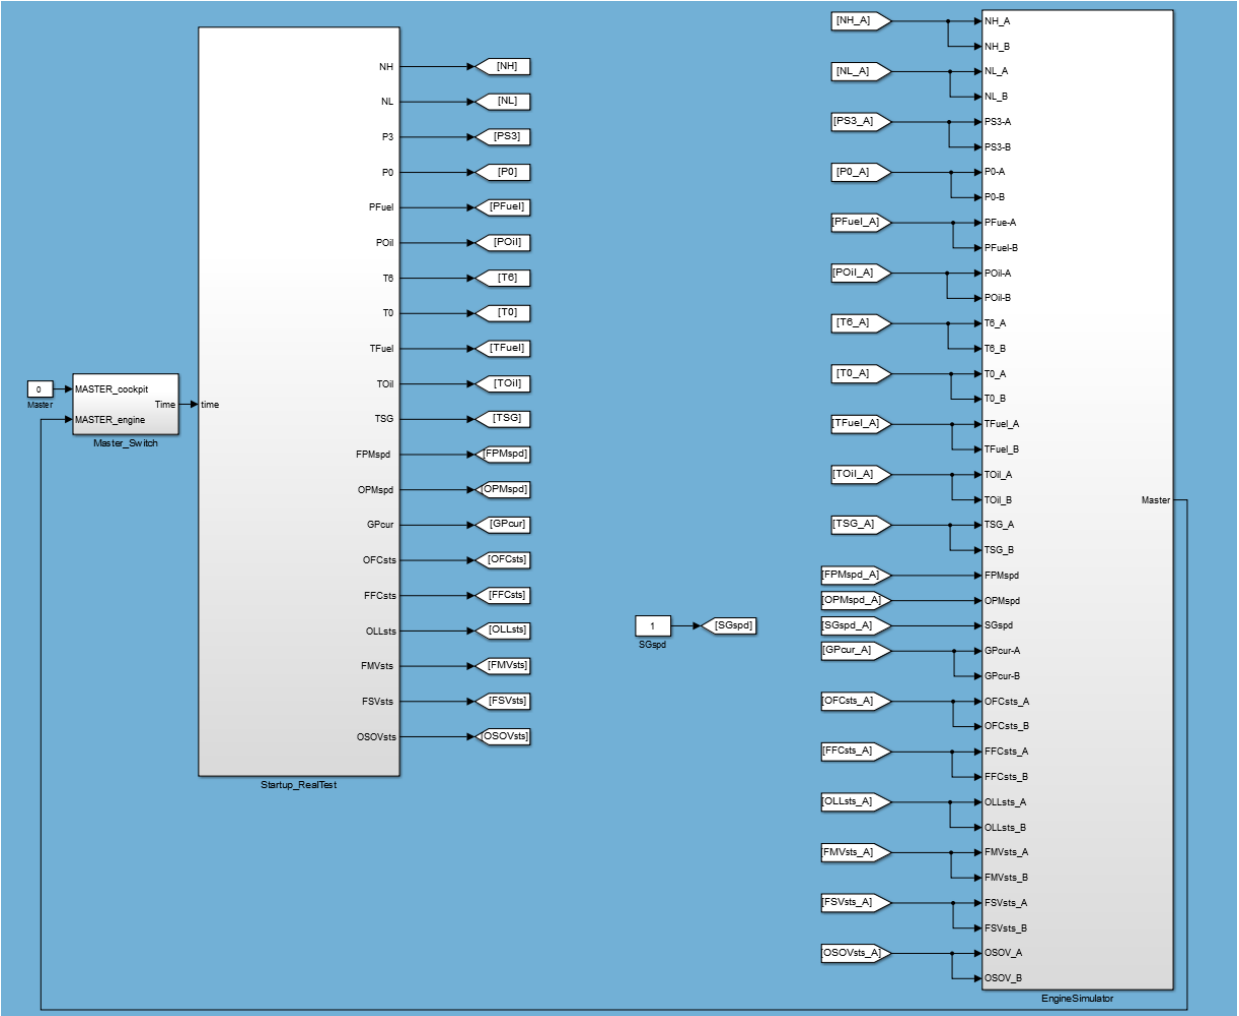
Figure 3. Real-time engine model of startup phase.